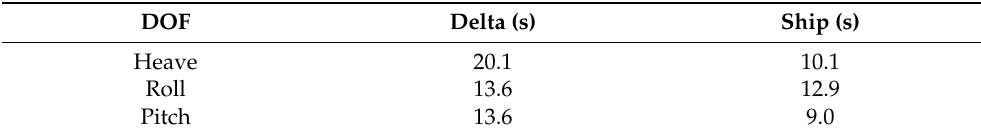
Table 3. Natural period of the Delta and the berthed